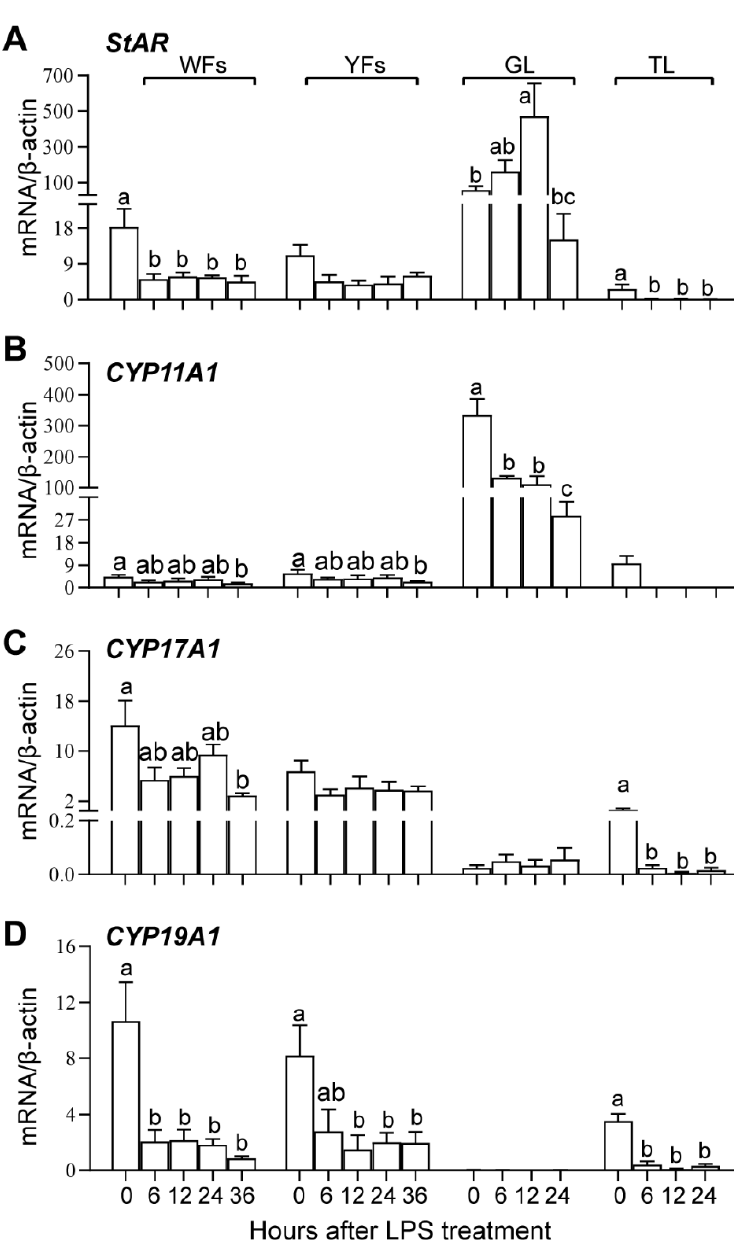
Figure 4. The gene expression of steroidogenic proteins StAR ( A ), Cyp11a1 ( B ), Cyp17a1 ( C ) and Cyp19a1 ( D ) during follicular growth and after LPS treatment. WFs, white follicles; YFs, yellowish follicles; GL, granulosa layer of the hierarchical follicles; TL, theca layer of the hierarchical follicles. Values with di ff erent letters are significantly di ff erent ( p <